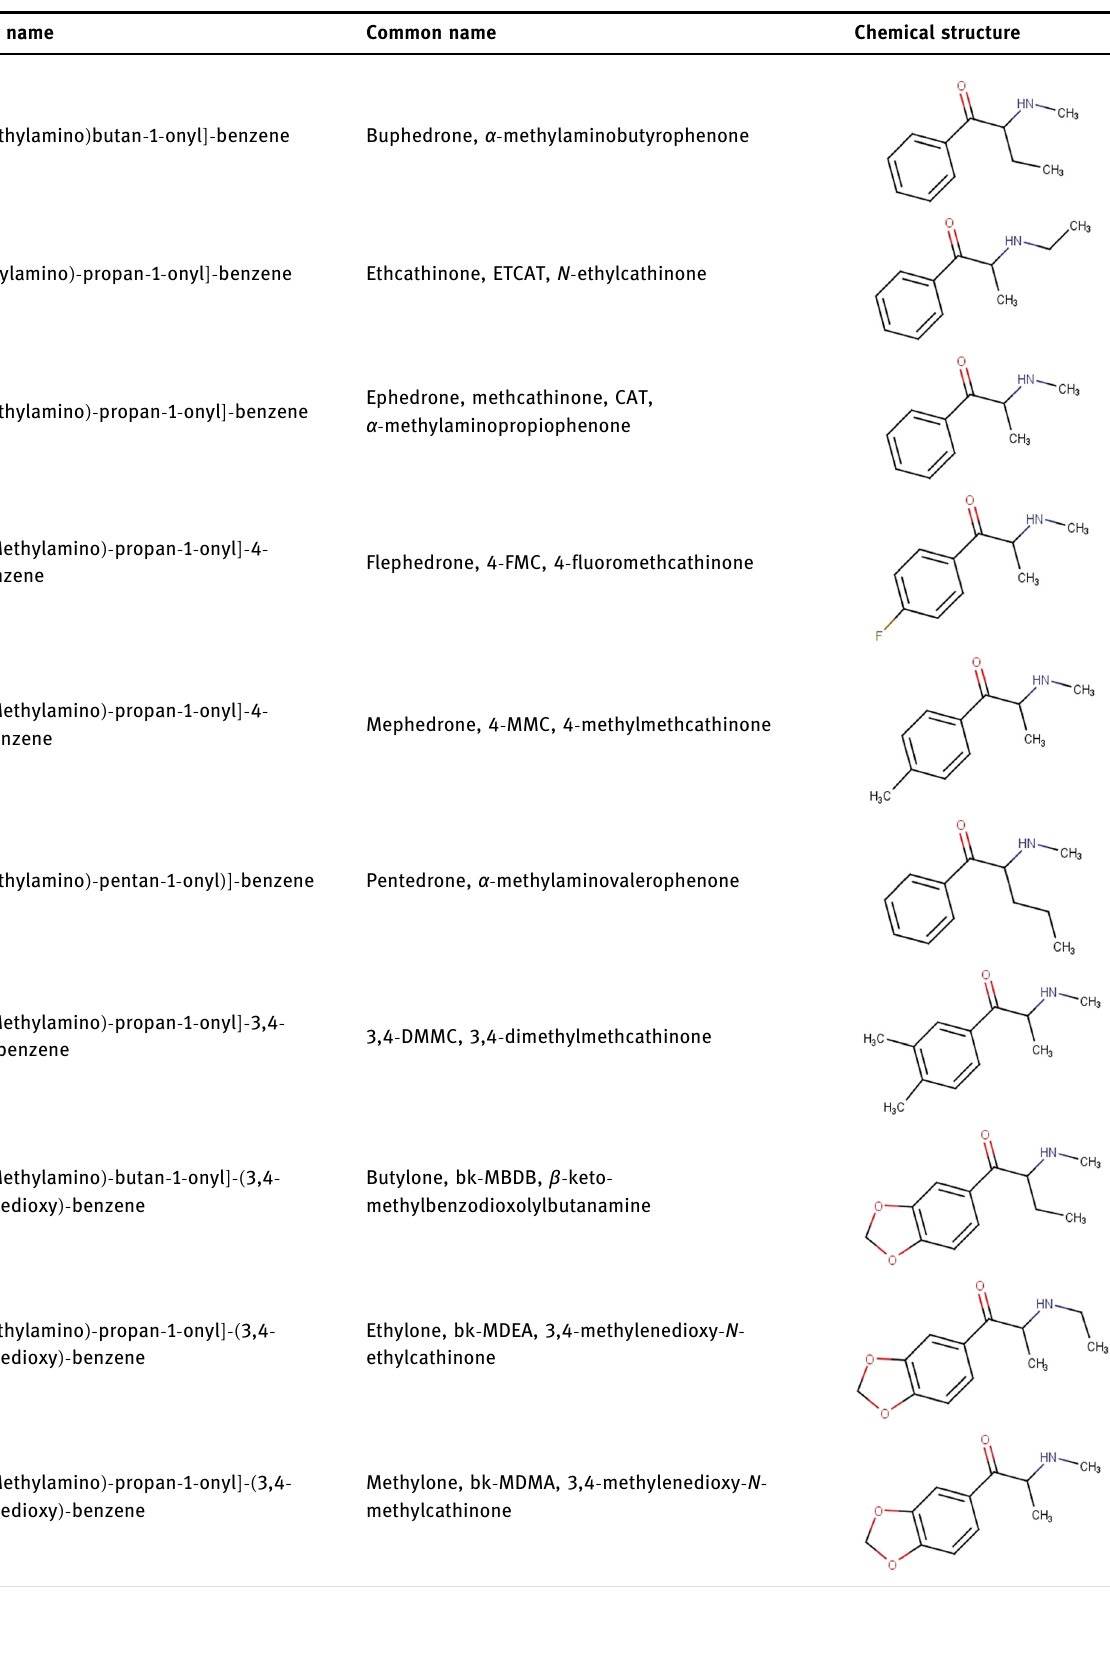
Table 2: Cathinone